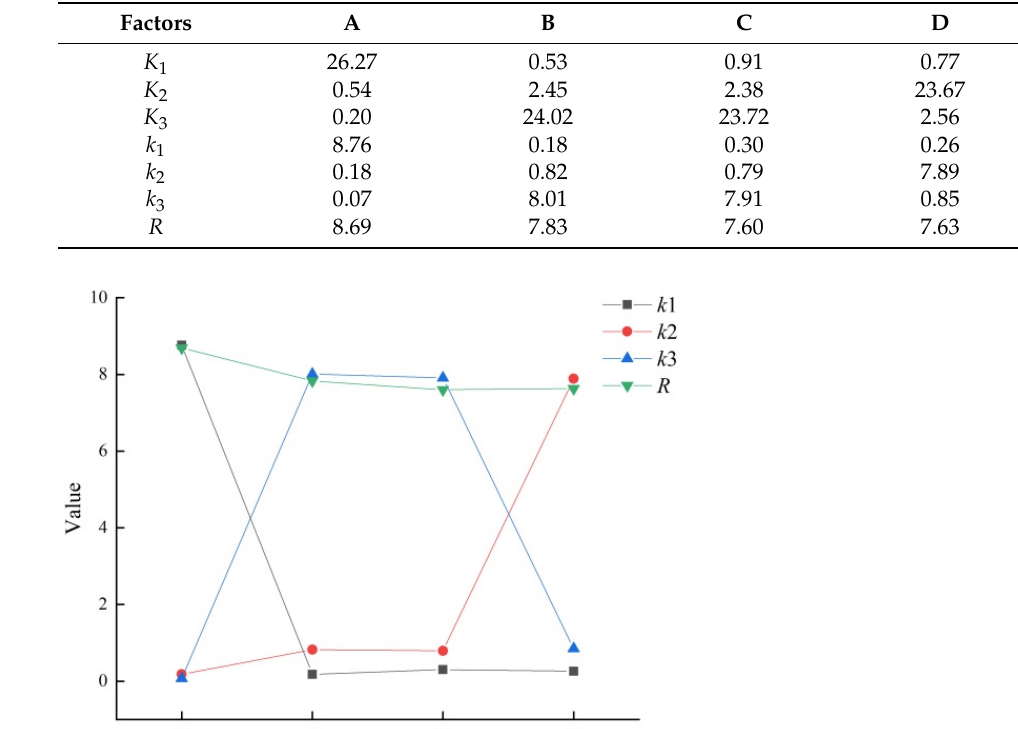
Table 5. Range analysis of the orthogonal experiment.